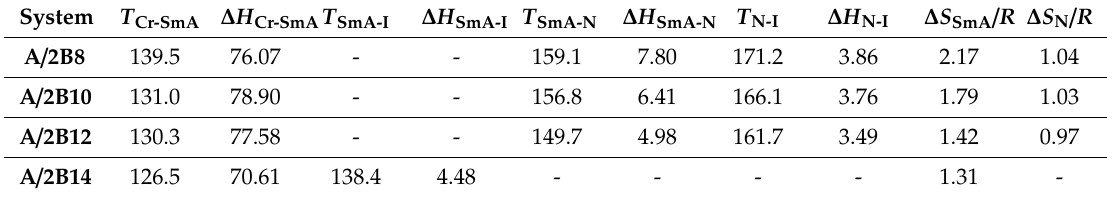
Table 1. Phase transition temperatures ( T , ◦ C), enthalpy of transitions ( ∆ H , kJ / mol) and normalized transition entropy ( ∆ S ) of supramolecular complexes A / 2Bn